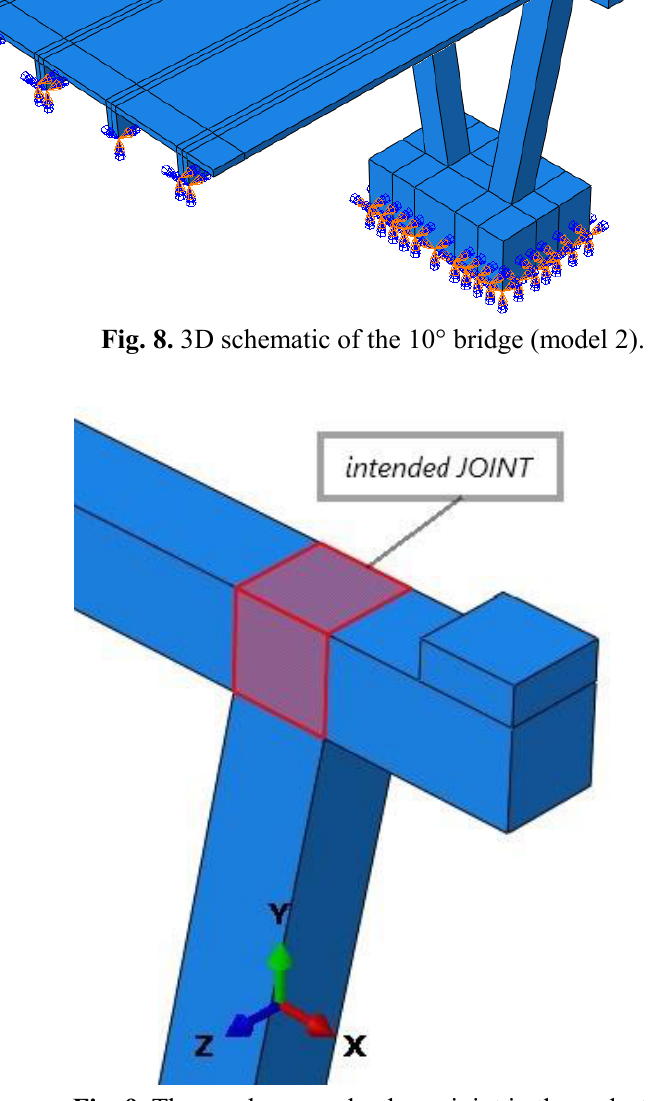
Fig. 9. The cap-beam and column joint in the